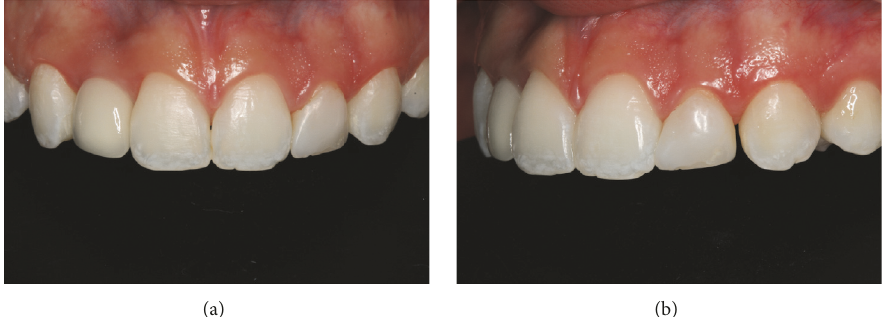
Figure 2: Detail of anterior teeth, showing imbalance of maxillary gingival arch harmony and unsatisfactory resin restoration on the left side lateral incisor. Front (a) and left (b) details of the maxillary anterior teeth.